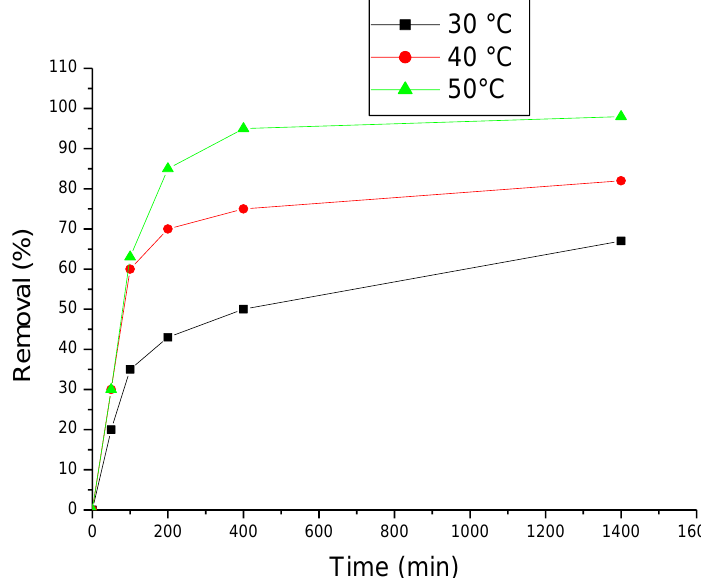
Figure 8. Effect of temperature (T) on methyl violet removal.